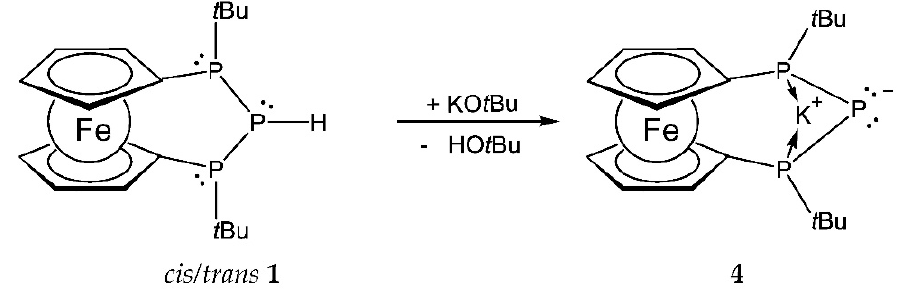
Figure 3. ORTEP plot of the molecular structure of 3 (Scheme 2; ( left )) and expansion of the folded P 3 Na ring ( right ). Ellipsoids were drawn at the 30% probability level. Hydrogen atoms were omitted for clarity.